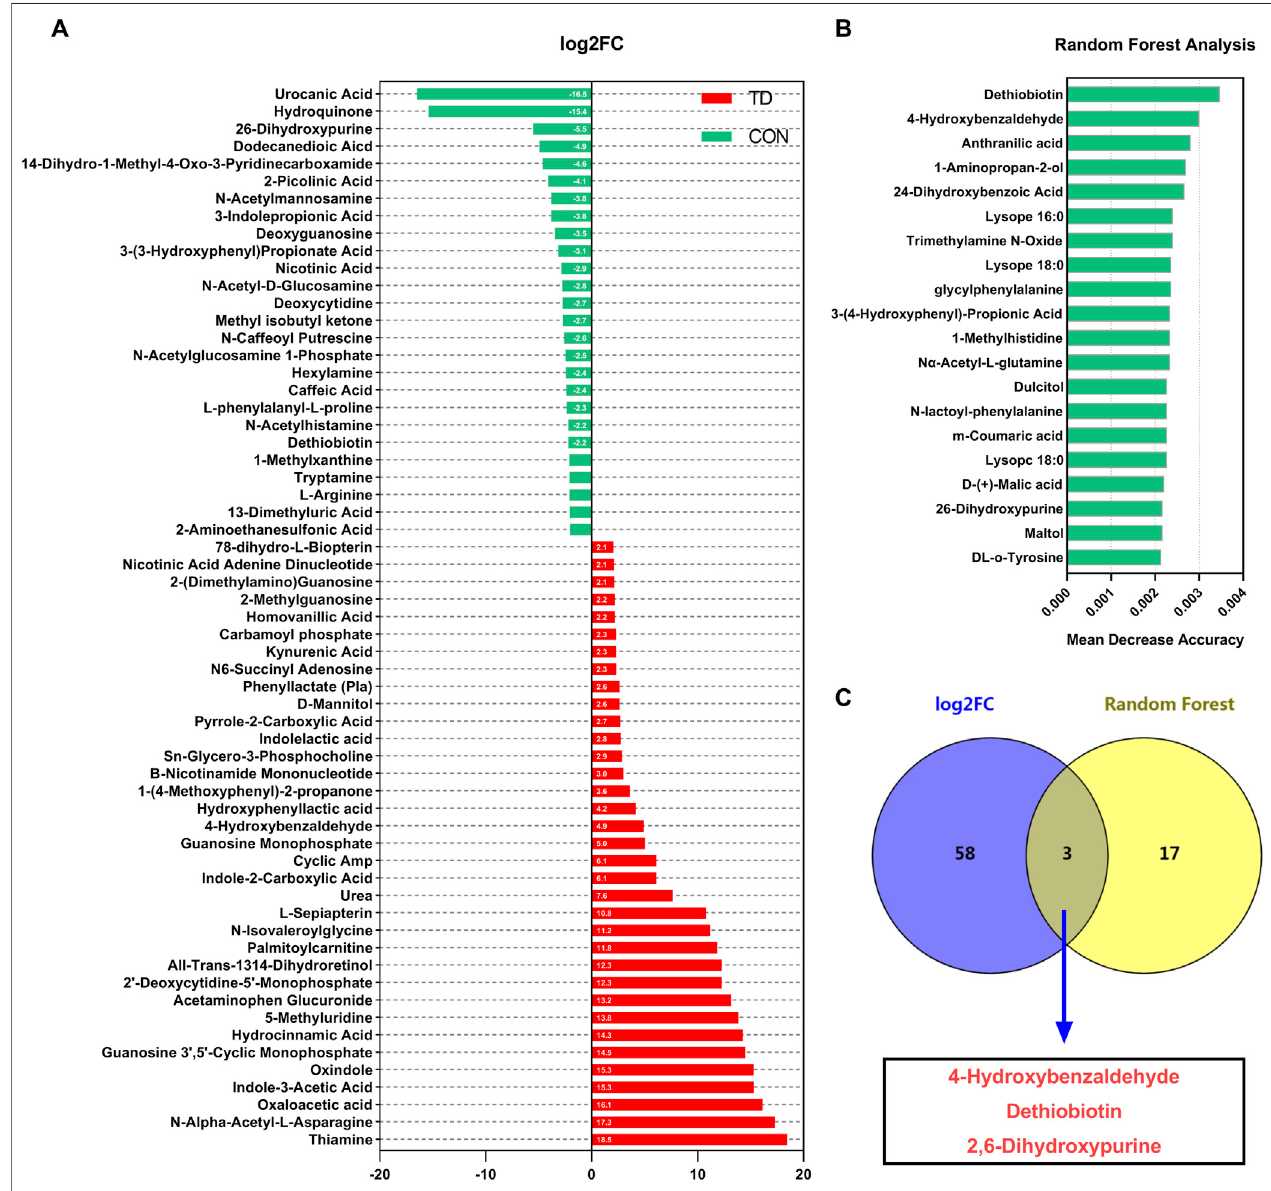
FIGURE 6 | Screening of differential metabolites in feces of broiler chickens. (A) Visualization of log2-transformed read counts of differentially metabolites in feces betweentheCONandTDgroups(|log2(FC)| ≥ 2.5and p < 0.05,FCstandsforfold-change,N=4). (B) Randomforestanalysisofdifferentialmetabolitesinfecesofbroilers in theCON and TD groups. The y -axis, from top tobottom, displays the taxa(TOP 20) ranked bytheirimportance (Mean Decrease Accuracy)forthegroup classi fi cation (C) Venn analysis was performed to screen differential fecal metabolites through log2FC and random forest model. The overlapping part of the Venn diagram represents the number of differential fecal microbiota in common between